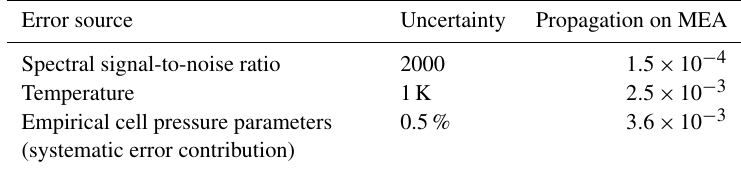
Table 3. Estimated error budget of the MEA (modulation efficiency amplitude) ILS parameter for the C 2 H 2 cell measurement